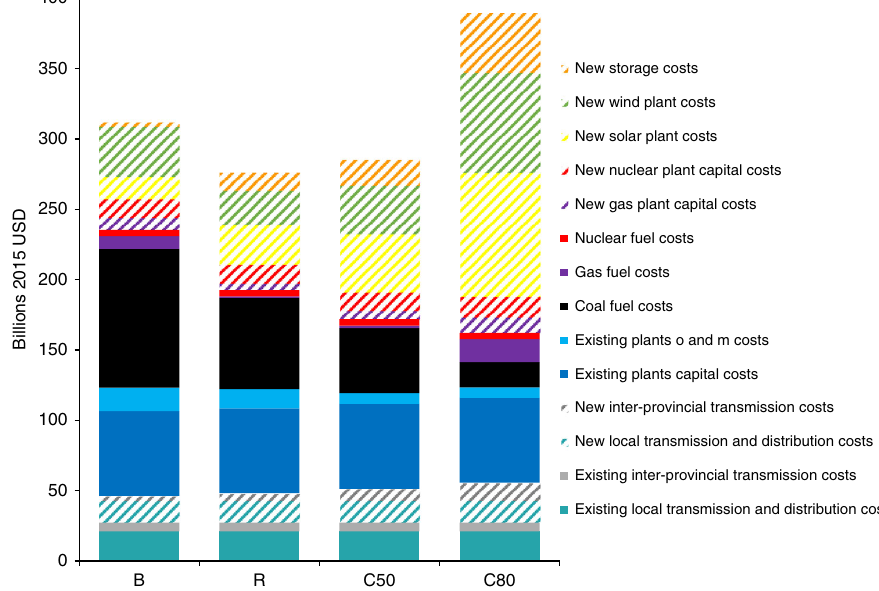
Fig. 5 Distribution and costs of power sources under four scenarios in 2030. The costs are categorized into existing and new capacity and transmission. Fossil fuel technologies and nuclear have fuel costs. Source data are provided as a Source Data fi